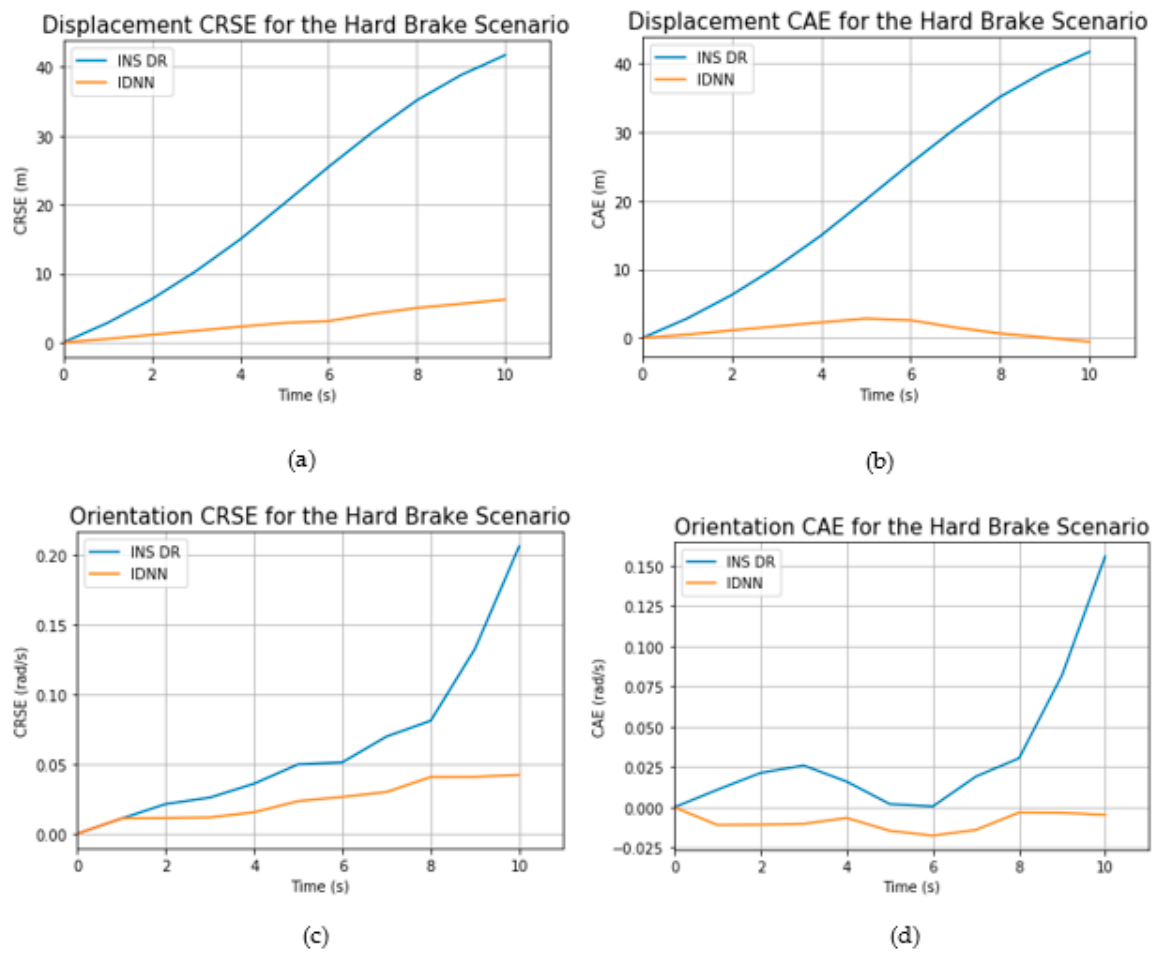
Figure 11. Showing the evolution of the estimation error over time in the hard brake scenario based on the ( a ) Displacement CRSE, ( b ) Displacement CAE, ( c ) Orientation rate CRSE and ( d ) Orientation rate